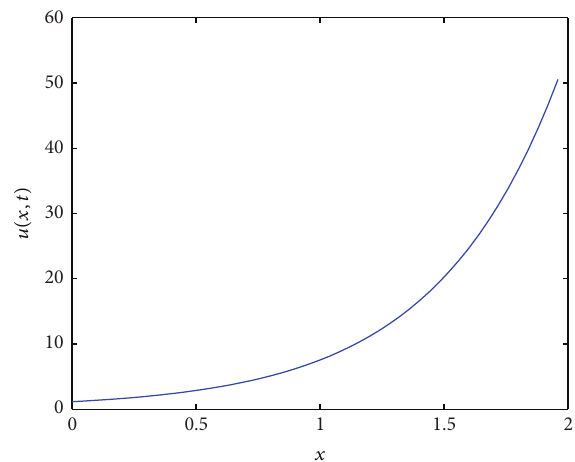
Figure 5: Plot of 𝑢(𝑥,𝑡) with respect to 𝑥 , 𝑥 ∈ [0,2] at 𝑡 = 1 for Example 2.